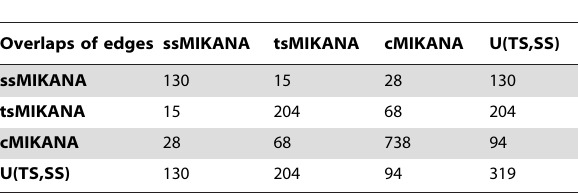
We computed the common edges overlapping among MIKANA network models reconstructed from a siRNA disruptant dataset (ssMIKANA), TNF time course measurements (tsMIKANA) and the combination of the two (cMIKANA). In addition, a union network (U(TS, SS)) was constructed by combining the tsMIKANA and ssMIKANA network models.